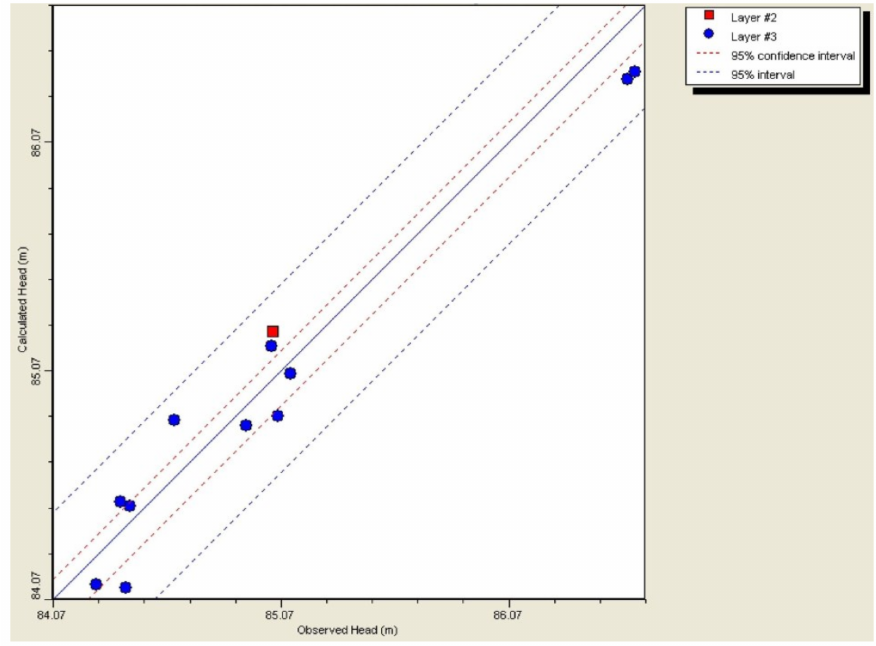
Figure 9. Observed versus calculated values of hydraulic heads for the period of an average precipitation.